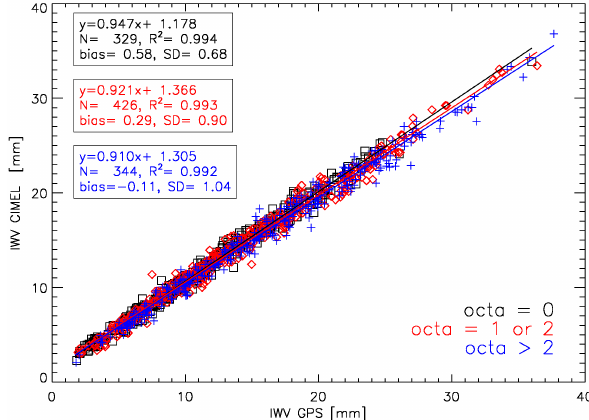
Figure 6. Scatter plot of coincident IWV measurements of the CIMEL instrument with the GPS device at Uccle, Brussels, Bel- gium for different classes of cloud